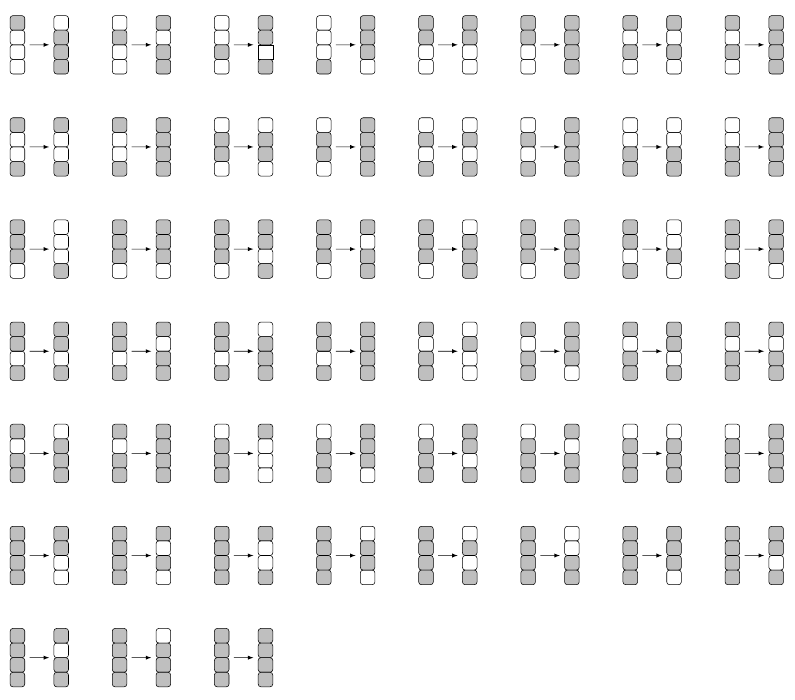
Figure 10: All possible transitions from active nibbles in a column to active nibbles after applying the Midori MixColumns matrix.